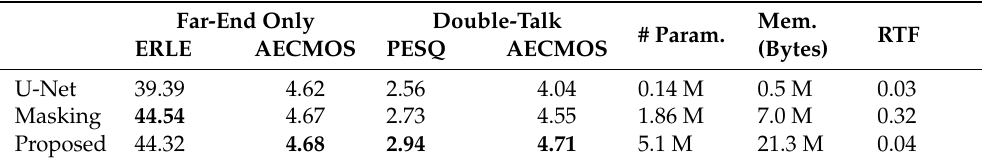
Table 4. Comparison of the proposed, the Residual-U-Net (U-Net), and the Complex-Masking (Masking) systems. Param. stands for parameters and Mem. for